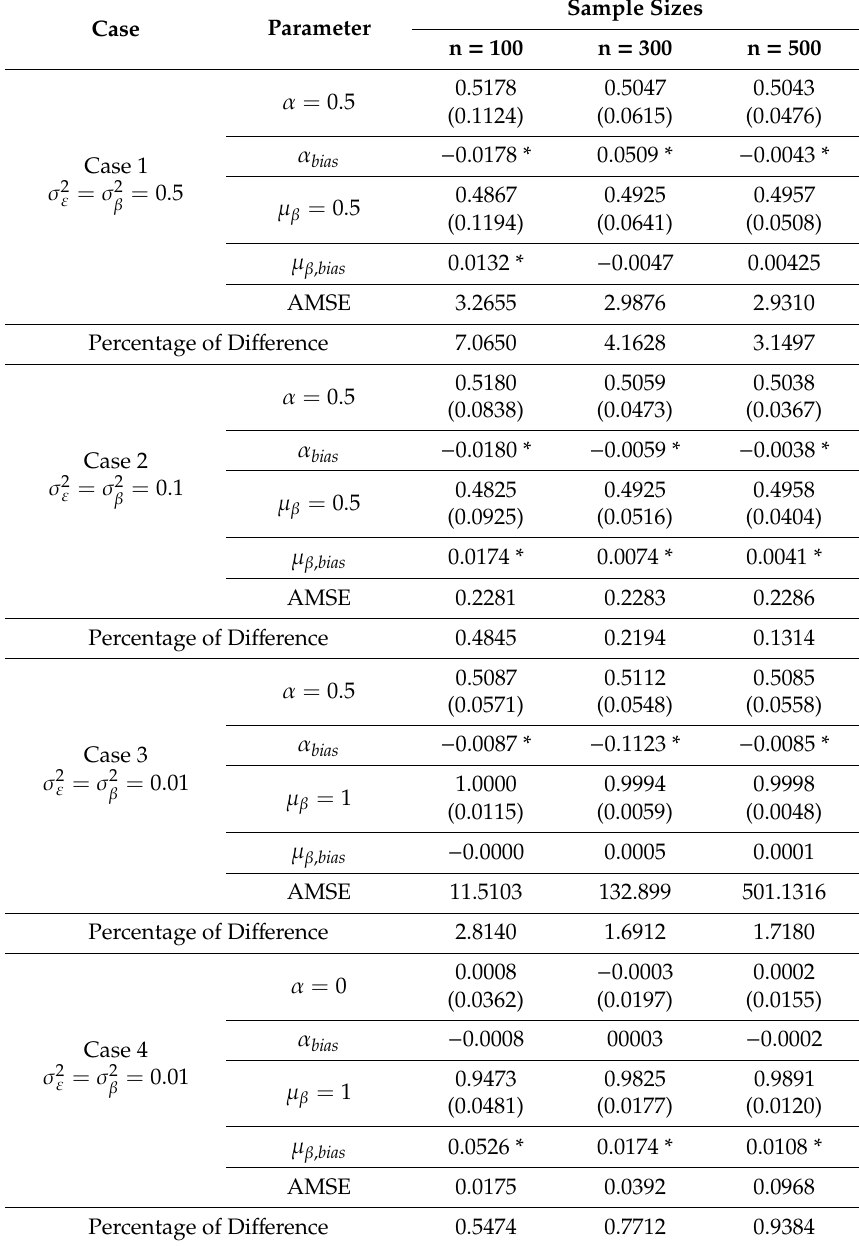
Table 2. The mean (sd), bias, AMSE, and percentage of di ff erences of parameter estimation in the maximum likelihood